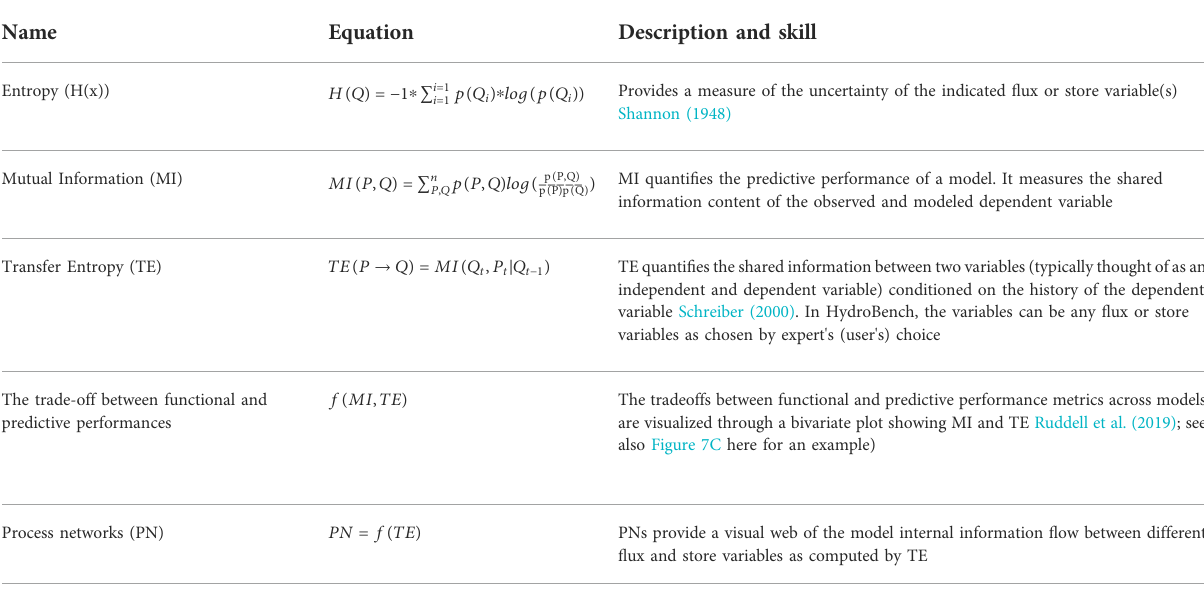
TABLE 3 List and description of information-theoretic model diagnostic metrics. Here, Q denotes stream fl ow, an example of the dependent variable of interest, and P denotes precipitation, an example of an input fl ux variable.